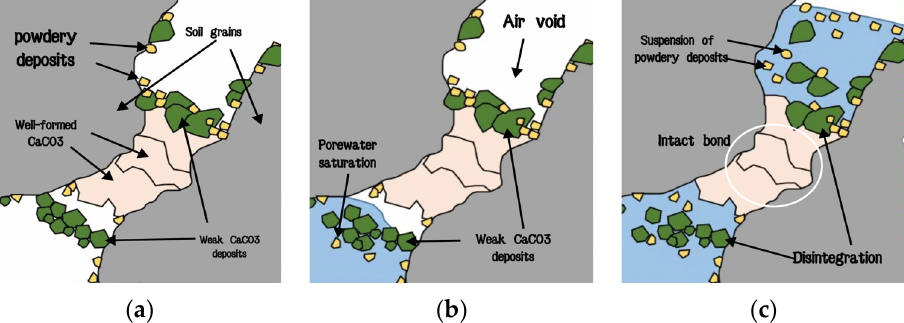
Figure 7. MICP soil infiltration diagram: ( a ) MICP soil diagram before wetting, ( b ) water infiltration into the pores, ( c ) saturated state.